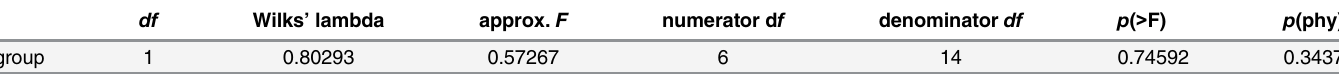
Table 2. Test statistics for the phylogenetic MANOVA. Species was used as the independent variable and relative enamel content per tooth position as the dependent variables. No significant influence of phylogeny was detected. df = degree of freedom, F = test value, p = significance level.